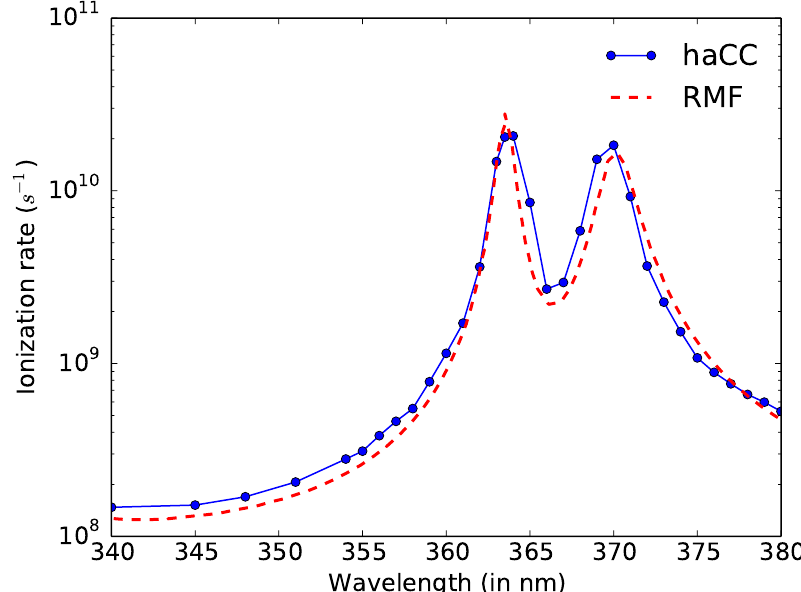
Figure 3. Five-photon ionization rates as a function of wavelength. The peak intensity of the laser fields used is 10 13 W/cm 2 . The RMF results are from